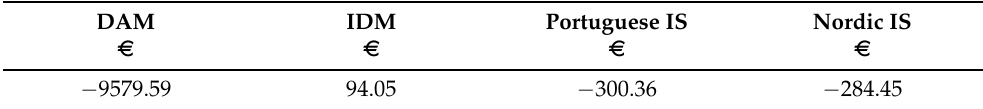
Table 1. Average hourly market outputs of the CEC on each market mechanism. DAM